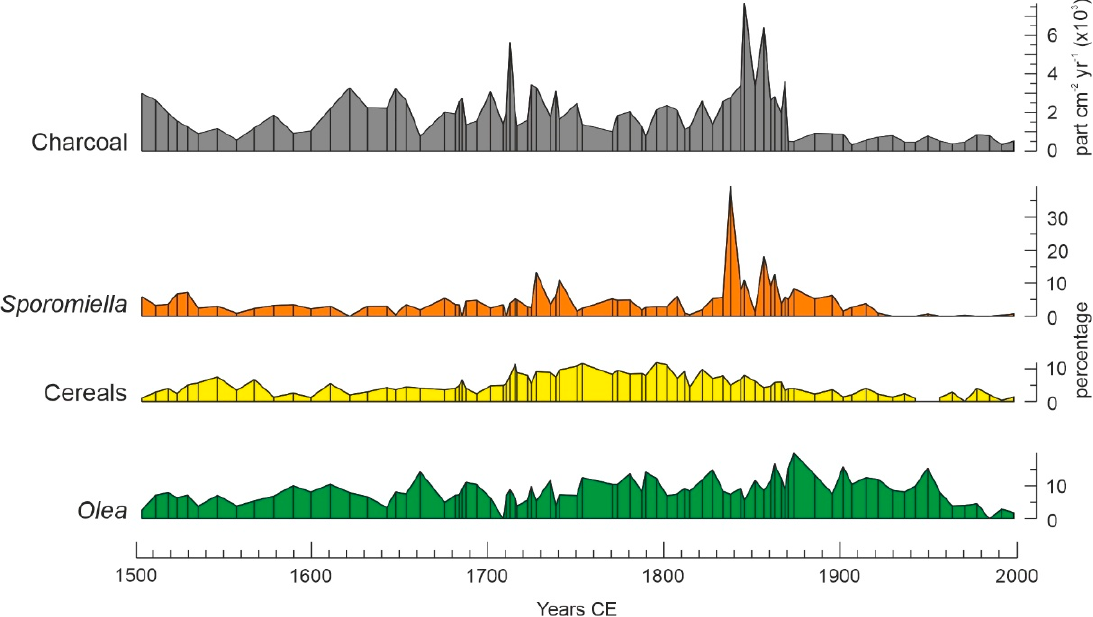
Figure 5. Diagram of the relevant anthropogenic proxies recalculated as in Figure 4. Cultivated trees are in green, cultivated herbs are in yellow, coprophilous fungi are in orange and charcoal is in gray.